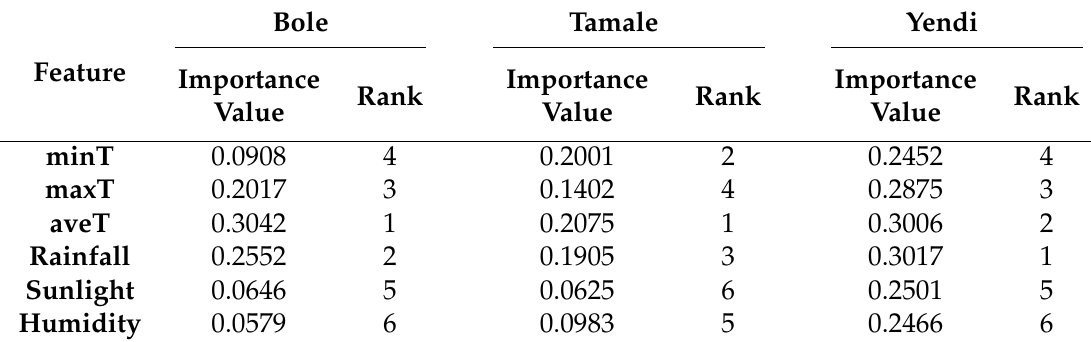
Table 2. Performance of evaluation metrics of the proposed stacking ensemble